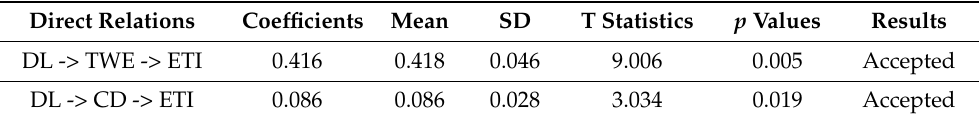
Table 8. Indirect